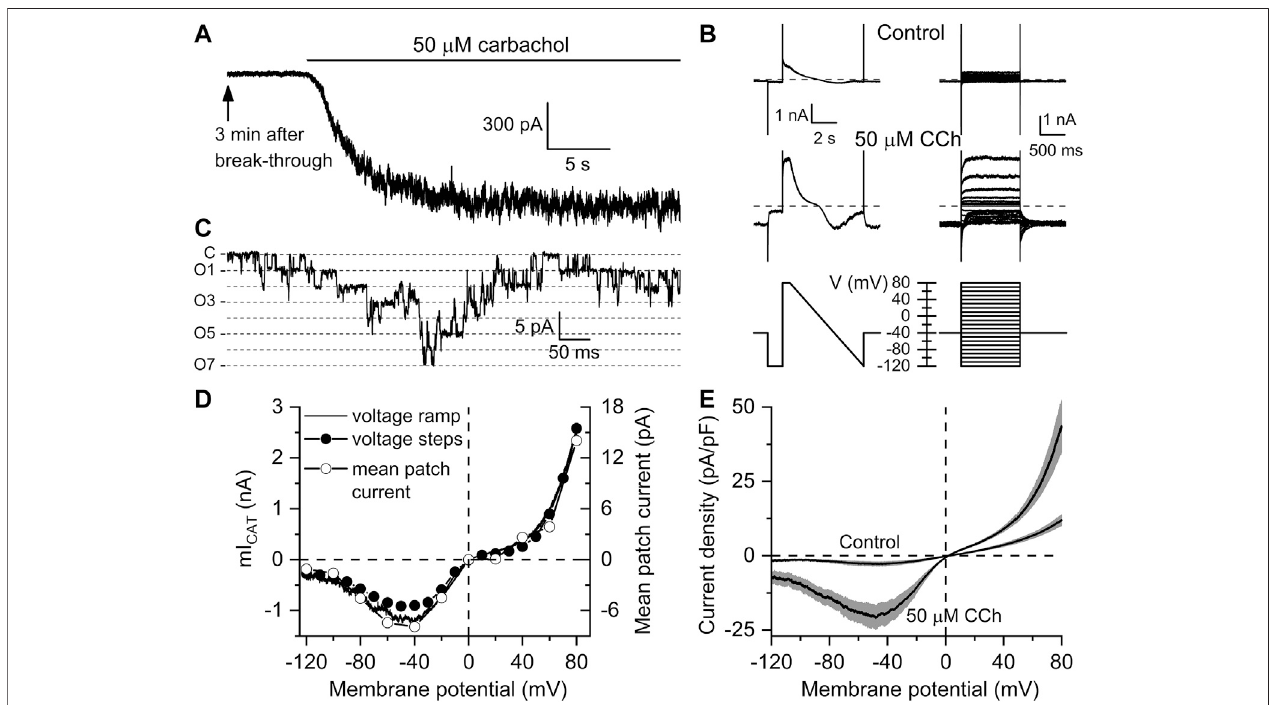
FIGURE 1 | Kinetics and voltage dependence of carbachol-induced mI CAT in mouse ileal myocytes. (A) Typical recording showing that 3 min after break-through (to allow complete equilibration of the cytosol with the pipette solution containing 125 mM Cs + that abolished any K + currents) carbachol applied at sub-maximal concentration of 50 µM induced a large inward current at the holding potential of − 50 mV. (B) Current kinetics and voltage dependence were assessed in the same cell shortly before carbachol application (top, control traces) and after mI CAT reached peak amplitude (middle traces) using two different protocols shown in bottom panels, either by applying slow (6 s) voltage ramp from 80 to − 120 mV (bottom left panel) or a series of 1.2 duration voltage steps applied from a holding potential of − 40 mVtodifferenttestpotentialsrangingfrom − 120to80 mVwitha10 mVincrementat5 sintervals(bottomrightpanel). (C) inthepresenceofthemuscarinicagonist, outside-out patch excision from the same cell revealed activity of multiple cation channels (C — closed state level, O1-O7 — multiple openings as shown by dashed lines) of60 pSsingle-channelconductancethatmainlymediatemI CAT (Dresviannikovetal.,2006;Tsvilovskyyetal.,2009). (D) I – VrelationshipsofmI CAT measuredinthesame cell with voltage ramp, at the end ofeach voltage step with voltage steps, aswell asmean patch currents recorded at differenttest potentials, asindicated. (E) Mean I – V curves measured in Ca 2+ , Mg 2+ -free, Cs + containing external solution 3 min after break-through in control and at the peak response to 50 µM carbachol ( n (cid:2) 8 in each case). Grey bands show S.E.M. values. In each cell, current amplitude was normalized by cell capacitance to calculate current density expressed in pA/pF. Mean cell capacitance was 33.9 ± 2.2 pF ( n (cid:2)